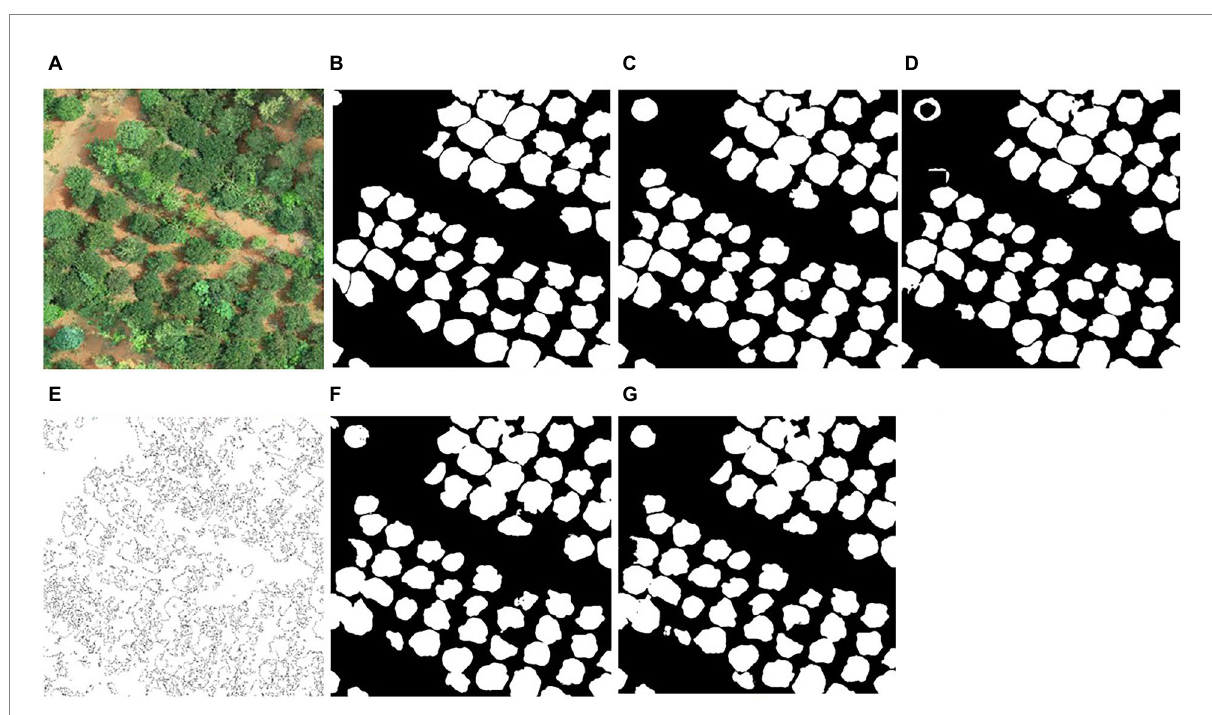
FIGURE 7 Comparison of tree-crown detection results between ResU-Net and other methods. (A) original image; (B) manually delineated result; (C–G) are examples of tree-crown detection using the ResU-Net model, DeepLabV3+ model, watershed algorithm, U-Net model, and U-Net++